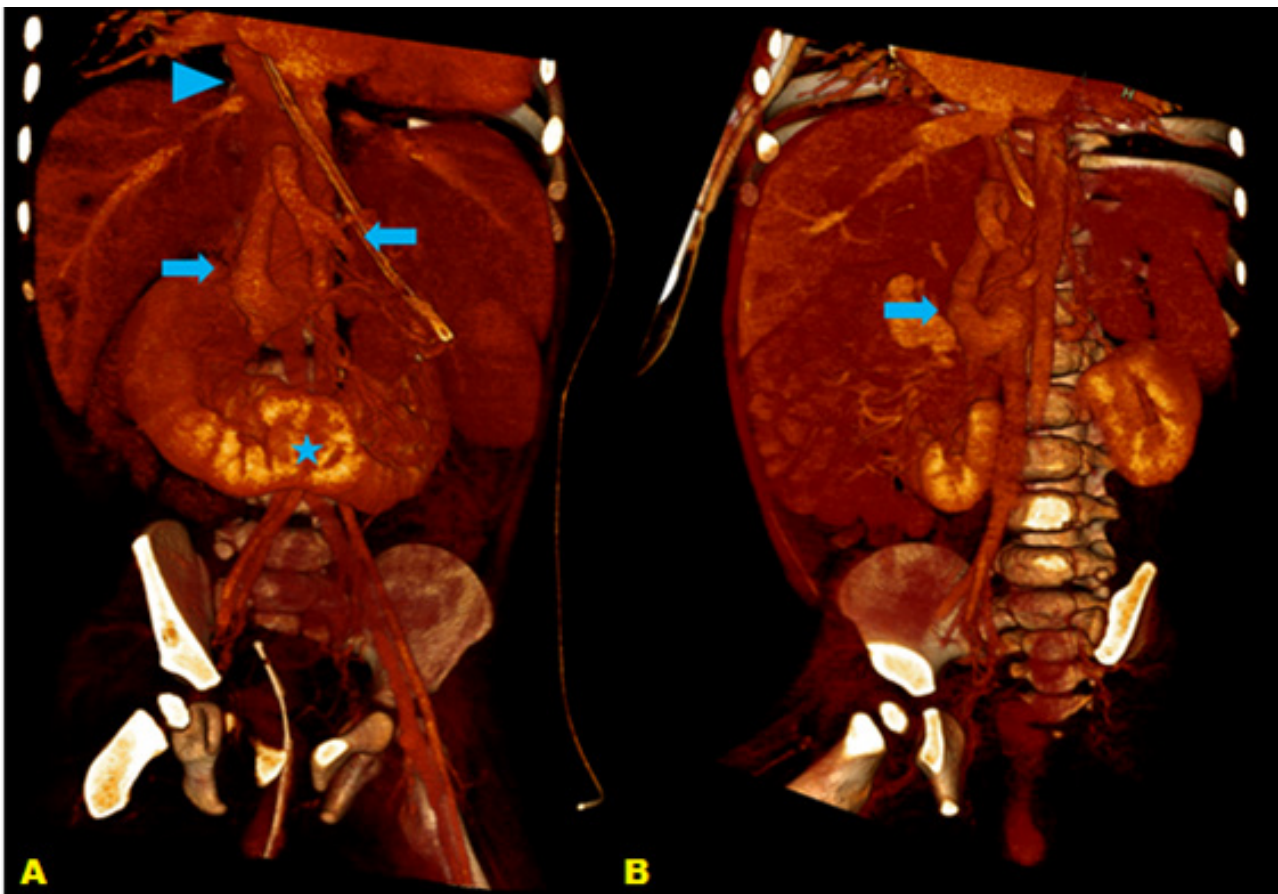
Fig. 4 - Coronal (A) and oblique (B) three-dimensional reconstructions of abdominal computed tomography, showing mesenteric-caval shunt (solid arrows) defining infrahepatic inferior vena cava engorgement, which continues with the azygos system at the thoracic level (arrowhead), best seen in A. Also, horseshoe kidneys (*) fused in the midline anterior to the abdominal